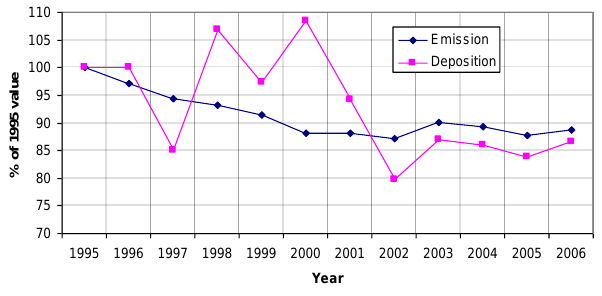
Fig. 9. Comparison of relative annual deposition of total nitrogen into the Baltic Sea basin and relative annual emissions of total (nitrogen oxides + ammonia) nitrogen from the HELCOM Contracting Parties in the period 1995 - 2006. Units: percent of 1995 value.